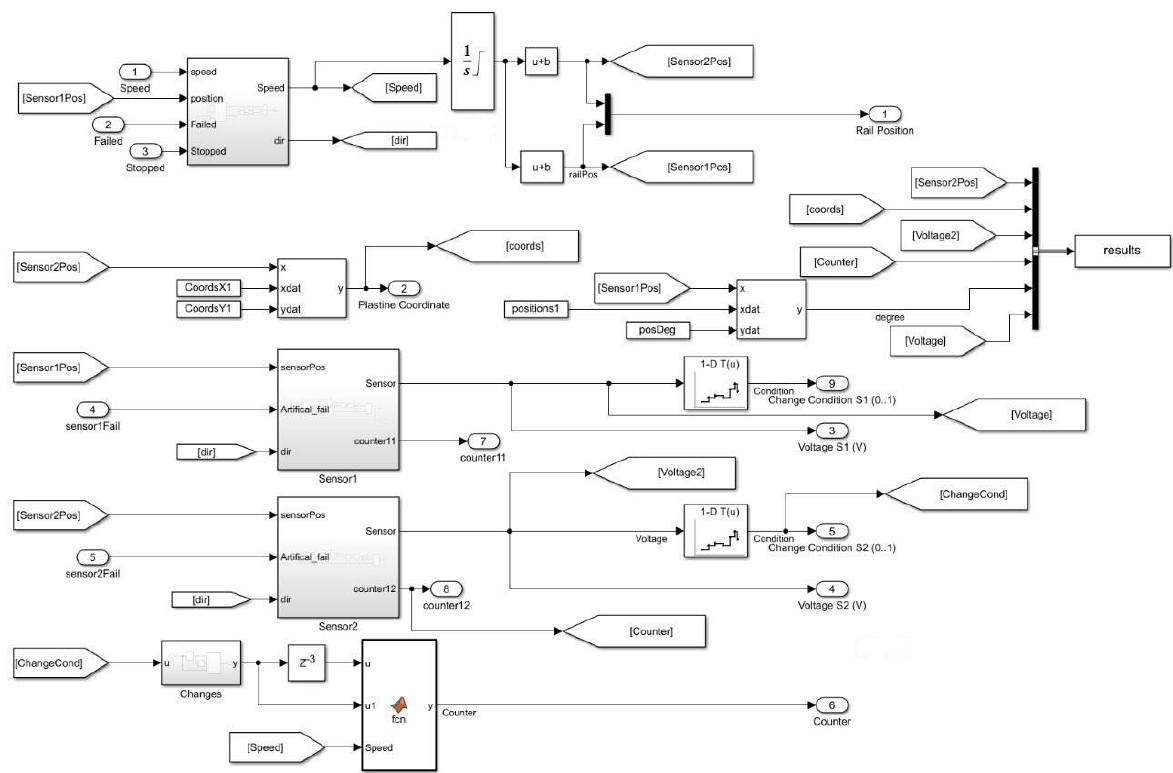
Figure 2. The modeling scheme of the “measuring bar—IPS” system.